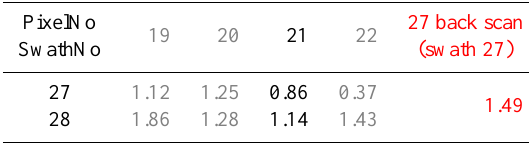
Table 4. Vertical SO 2 column densities in 10 17 molec/cm 2 for the GOME-2 forward scan pixels overlapping with that back scan where the maximum of 1.49 × 10 17 molec/cm 2 in SO 2 is observed. In black are those pixels that are also probed by CARIBIC and in grey are the neighbouring